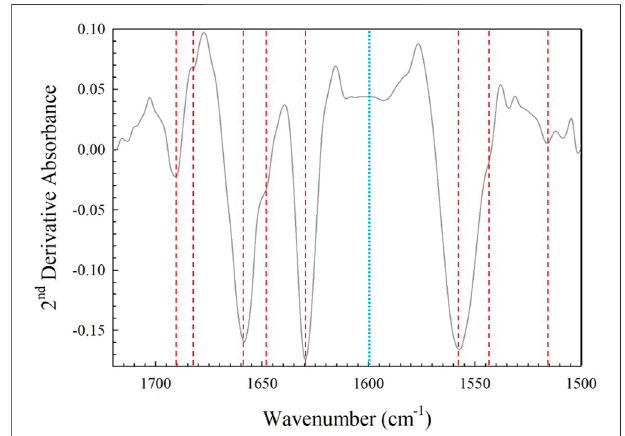
FIGURE 7 | Second derivative spectrum of the amide I and II band region. The main peaks identi fi ed from amide I (1690, 1682, 1658, 1646 and 1630 cm − 1 )andII(1556, 1556,and~1525 cm − 1 )secondderivativespectrum (red dashed lines) and peak corresponding to areas where absorbance is measured between main peaks (blue dotted